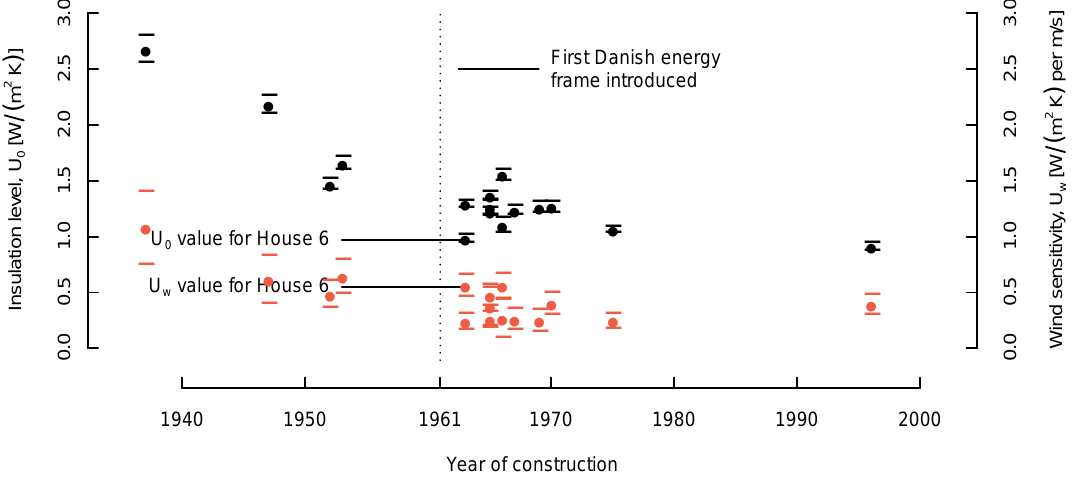
Figure 6. Plot of U 0 and U W per heated floor area as function of construction year. The black dots (left axis) show a clear increment in insulation level as the year of construction becomes more recent. The red dots (right axis) show the sensitivity to wind, e.g., the level of air